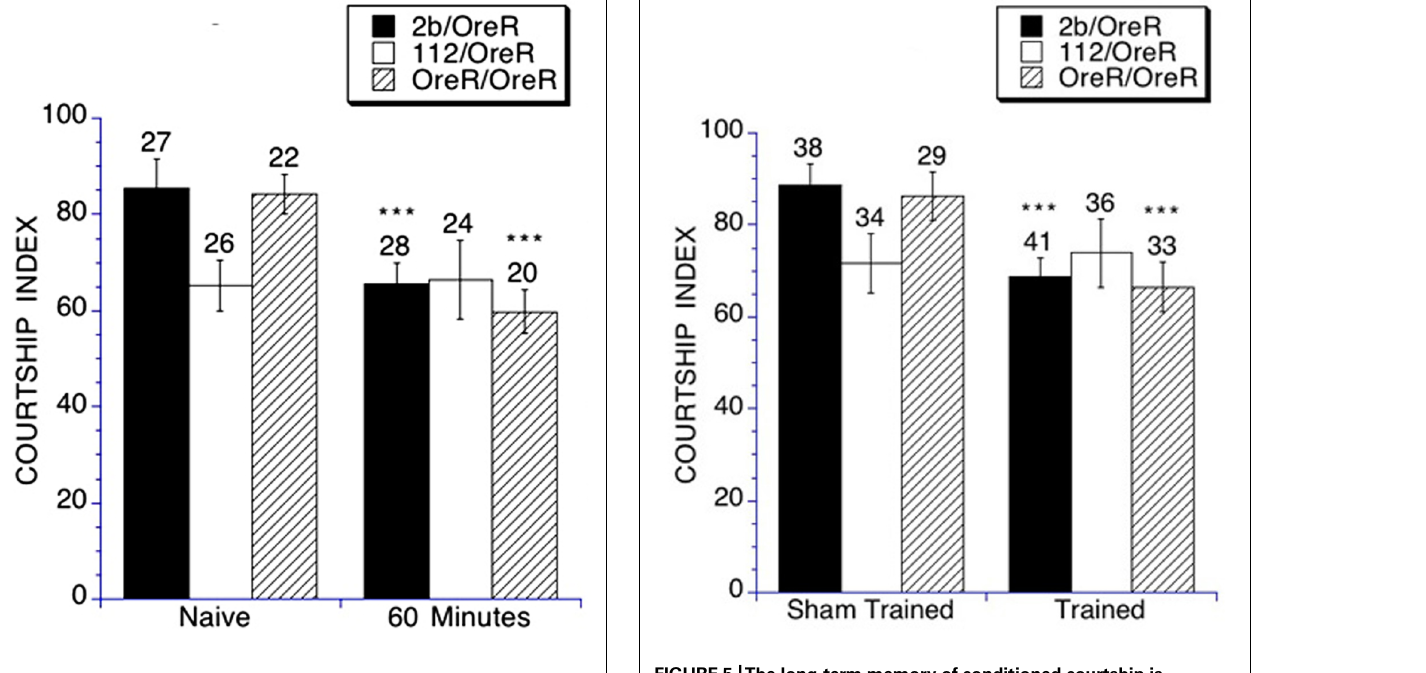
FIGURE 5 |The long-term memory of conditioned courtship is impaired in heterozygous DmGluRA 112 mutant flies. For long-term memory, males were either paired with a non-receptive female for 7 h or sham trained (also referred to as naïve trained) in the absence of a female for the same period.The males from both training classes were then kept in isolation for 4 days then paired with a virgin female, and monitored for courtship activity.The resulting CI after training is compared to the CI obtained for naïve courtship. Mean CIs ( ± SEM) are plotted; Ns are indicated above each bar for all groups. For levels of significance, *** p < 0.001. Control DmGluRA 2b flies (filled black bars) and control OreR background flies (striped bars) exhibited intact long-term memory as demonstrated by a significant depression of courtship activity in the trained versus the naïve groups.The DmGluRA 112 mutant flies (open bars) did not demonstrate a suppression of courtship activity after training and therefore had impaired long-term